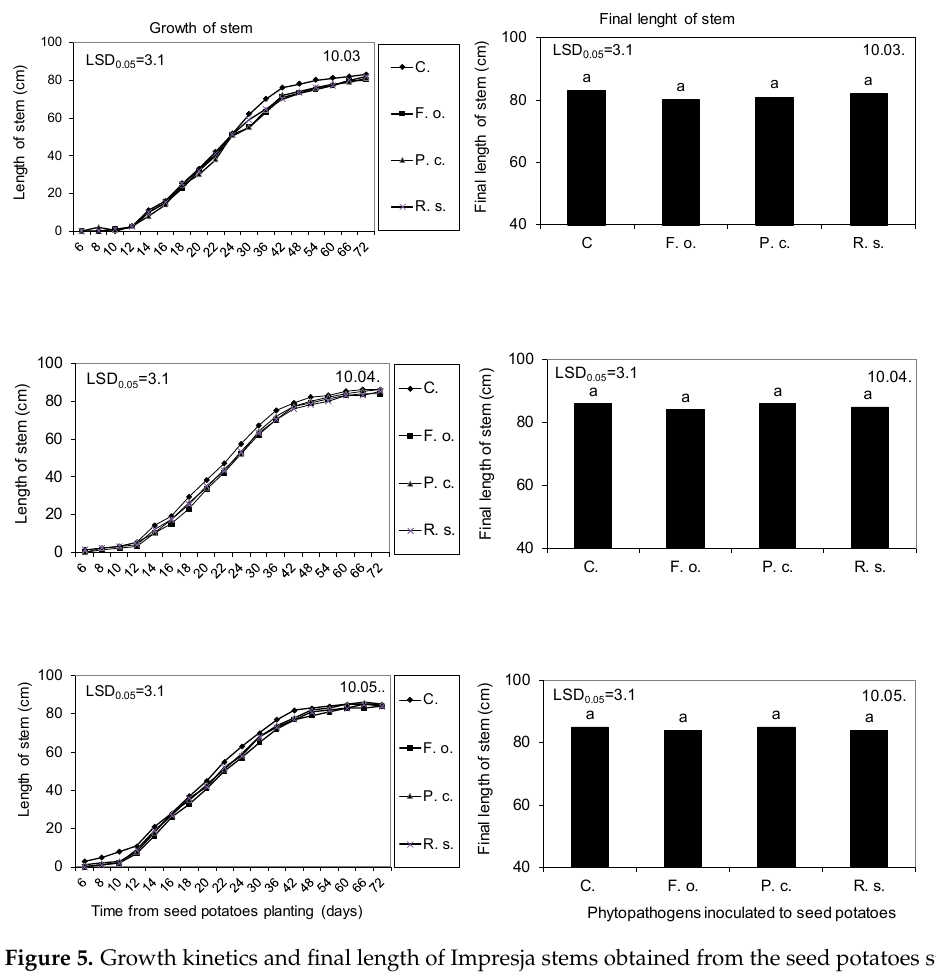
Figure 5. Growth kinetics and final length of Impresja stems obtained from the seed potatoes stored at 4 °C from harvest until inoculation with phytopathogens on 10 February and then at 15 °C and 80% RH before planting in the soil on 10 March, 10 April, and 10 May. C—Control, Fo— F. oxysporum , Pc— P. corotovorum , Rs— R. solani . Means marked with the same letters do not differ statistically at the significance level p = 0.05. LSD was calculated at the significance level of p = 0.05.